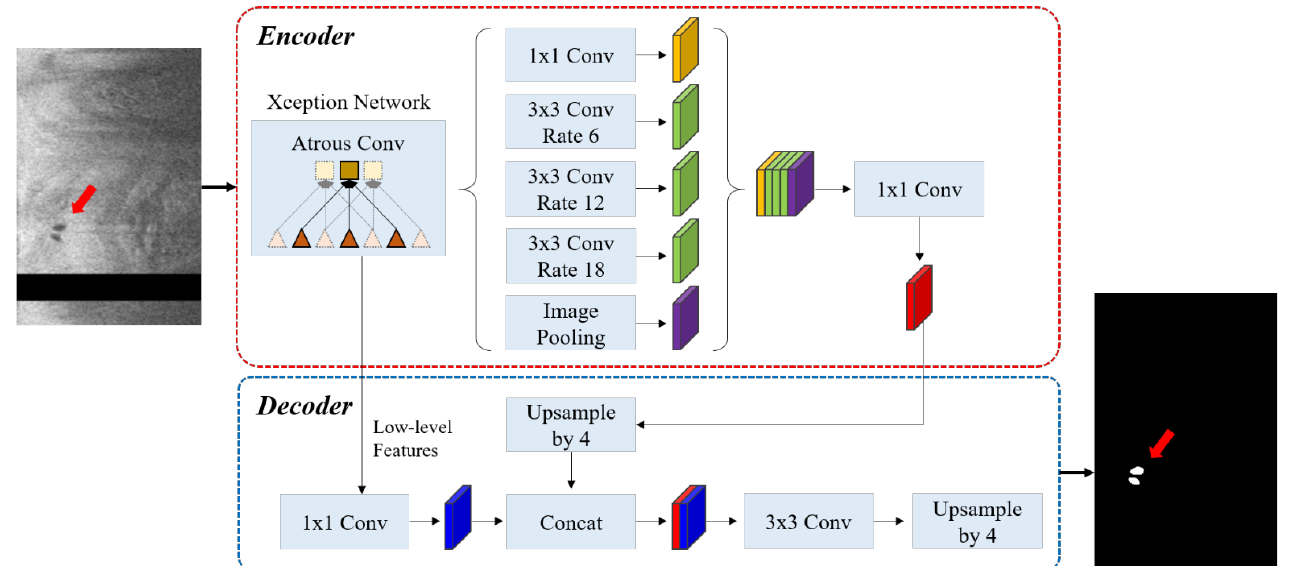
Figure 1. The DeepLab v3 plus network consists of atrous convolution, atrous spatial pyramid pooling, and encoder–decoder. The Xception network was used as the backbone network for feature extraction. The left and right figures are the pre-processed IVOCT image and predicted label, respectively (red arrow: microvessel). The sizes of input and output images are the same (200 × 448 pixels). In the input image, the black strip indicates the guidewire shadow removed during pre-processing.